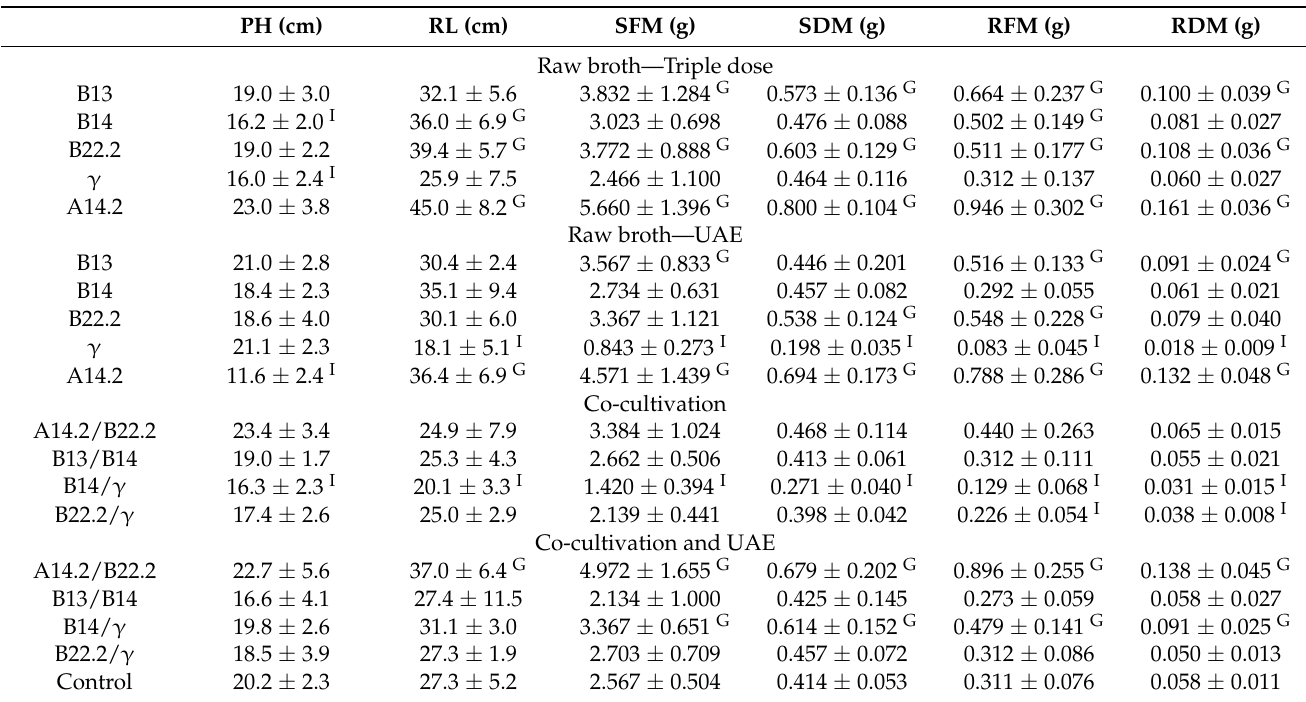
Table 4. Effects of metabolites from the crude broth, triple dose, and PF-UAE, as well as co-cultivation, and co-cultivation with PF-UAE on A. hybridus parameters at 14 days after application